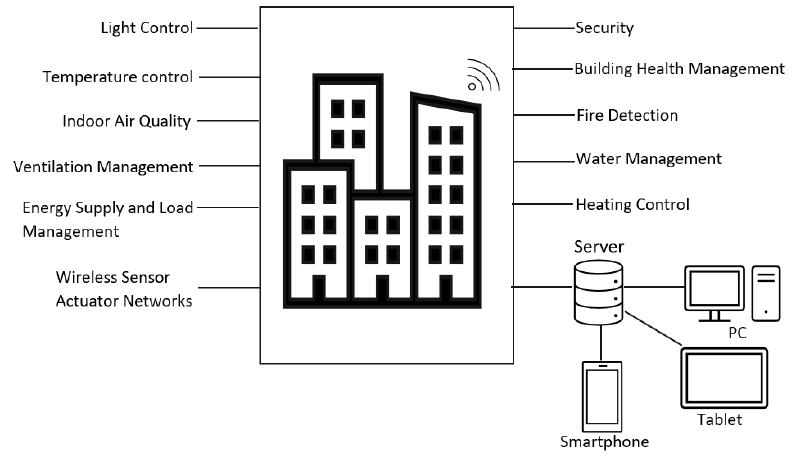
Figure 10. The elements should be included in a conceptual illustration of an intelligent building